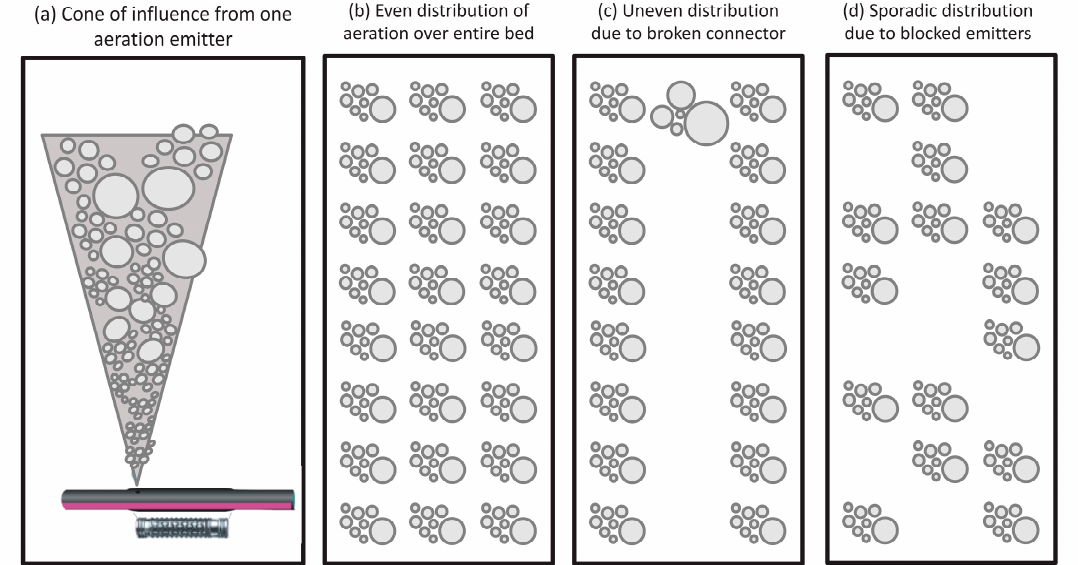
Figure 4. Bubble patterns in aerated treatment wetlands: ( a ) Visualization of the cone of influence created by one aeration orifice; ( b ) even bubble distribution across the entire bed; ( c ) uneven distribution where one connector is broken, allowing excess air to escape through the break in the airline nearest to the aeration manifold; ( d ) sporadic bubble pattern indicative of blocked emitters.